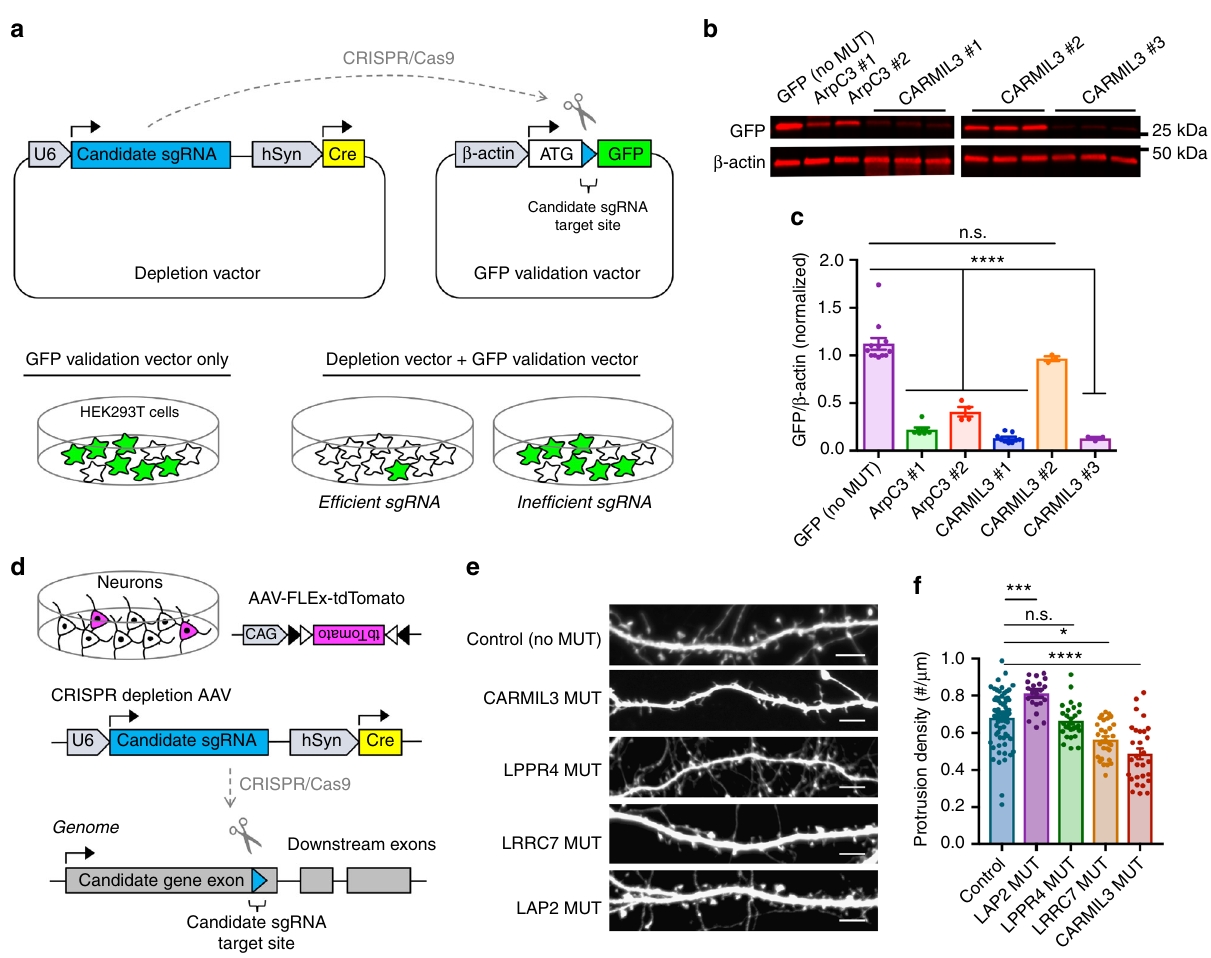
Fig. 3 Candidate screening for functional role in fi lopodia maturation. a Schematic depicting the depletion and GFP validation vectors for in vitro guide screening. U6 U6 promoter, sgRNA single guide RNA, hSyn human Synapsin I promoter, Cre cre recombinase, β -actin beta actin promoter, GFP green fl uorescent protein. b Representative blot for GFP to validate depletion ef fi ciency of sgRNA sequences. c Graphical representation of GFP/ β -actin intensity relative to no depletion control (GFP alone) (1.12 ± 0.06 GFP intensity, n = 12 HEK cell samples), ArpC3 #1 (0.22 ± 0.02, n = 7 samples), ArpC3 #2 (0.41 ± 0.05, n = 4 samples), CARMIL3 #1 (0.13 ± 0.02, n = 9 samples), CARMIL3 #2 (0.97 ± 0.02, n = 3 samples), CARMIL3 #3 (0.10 ± 0.01, n = 3 samples), LPPR4 #3 (0.04 ± 0.00, n = 6 samples), LRRC7 #3 (0.06 ± 0.01, n = 3 samples), and LAP2 #1 (0.02 ± 0.01, n = 3 samples). F 8,41 = 85.192, p <0.0001. d Schematic depicting CRISPR depletion of candidates in cultured hippocampal neurons. e Representative images of dendritic morphology for each group of virally mediated depletions. Scale bars are 5 μ m. f Graphical representation of dendritic protrusion density for each group of virally mediated depletions, Control (66 ± 2 protrusions, n = 66 neurons), LAP2 (81 ± 2 protrusions, n = 22 neurons), LPPR4 (66 ± 2 protrusions, n = 27 neurons), LRRC7 (56 ± 2 protrusions, n = 30 neurons), CARMIL3 (49 ± 3 protrusions, n = 29 neurons). Error bars are standard error of the mean (SEM). F = 24.55, p <0.0001. * p <0.05, 4,169 *** p <0.001; **** p <0.0001, one-way